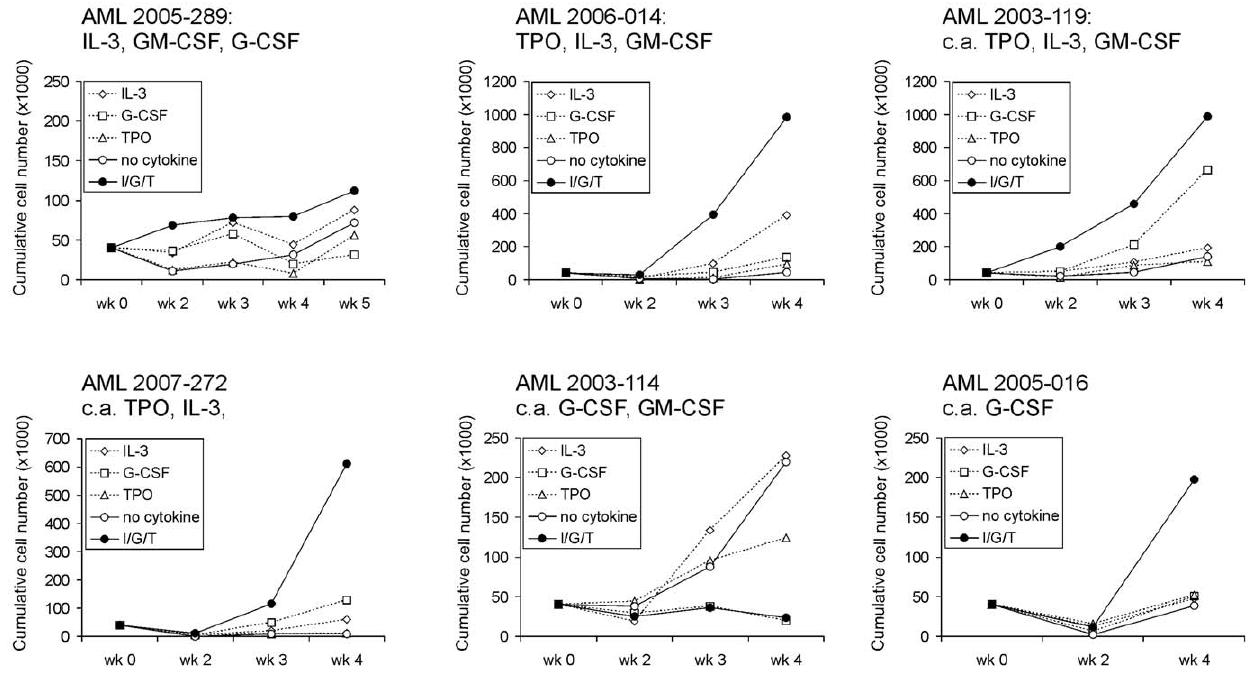
Figure 4. Variability in cytokine-dependent long-term expansion of AML CD34 + cells on MS5 stroma. 4 6 10 5 AML CD34 + cells were sorted and plated in 12-well plates precoated with MS5 stromal cells. Cells were expanded in LTC medium supplemented with 20 ng/ml IL-3, G-CSF, TPO, combinations thereof, or without any cytokines. Cultures were demi-depopulated weekly for analysis. Weekly cumulative cell counts represented cells in suspension. The cytokines above the figures indicate which cytokines were able to induce STAT5 phosphorylation. c.a. indicates constitutive activation of STAT5.